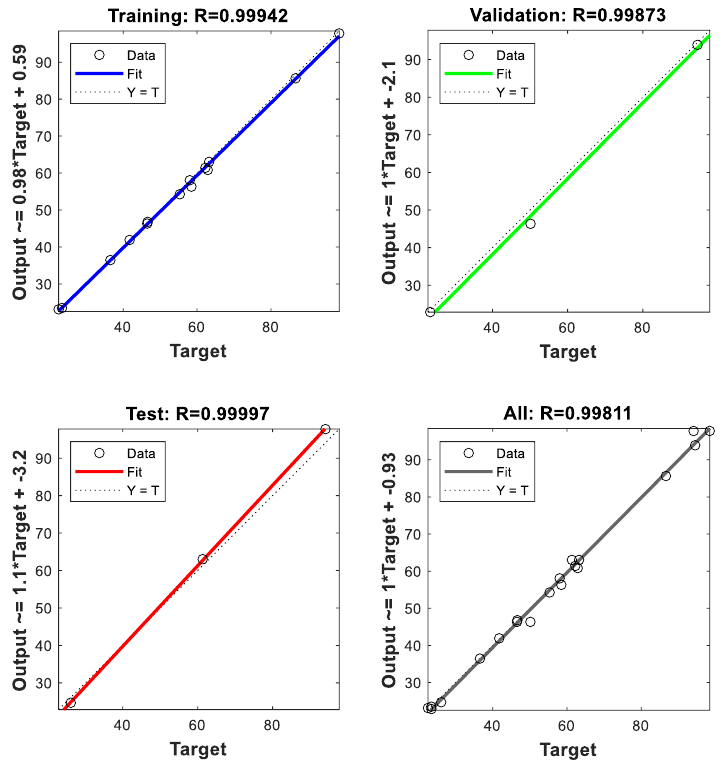
Figure 6. Correlation coefficient for experimental and predicted values by back-propagation DNN